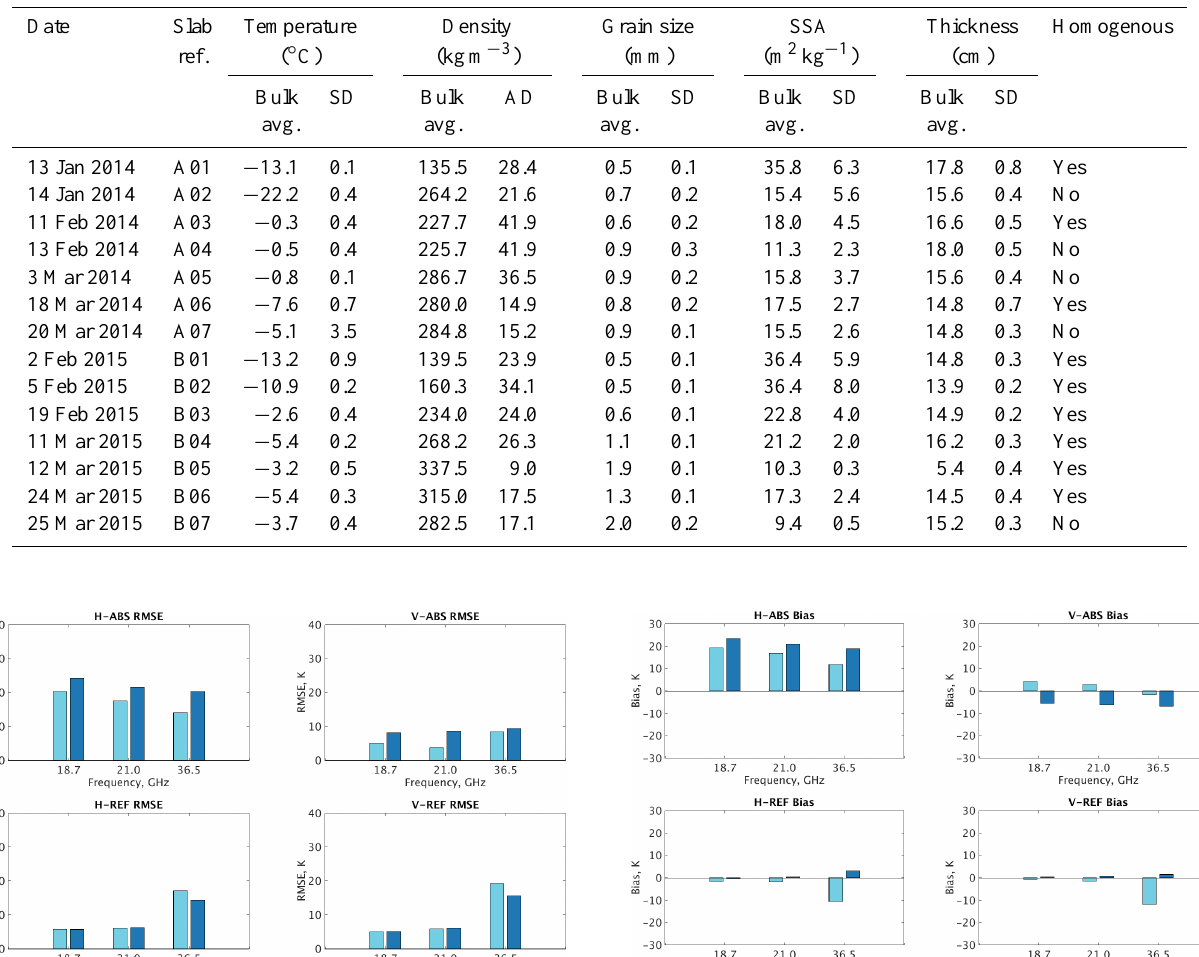
Table 3. Averaged results from macro- and microstructure measurements. It should be noted that slab A03 was wet, so was not considered for model simulation.